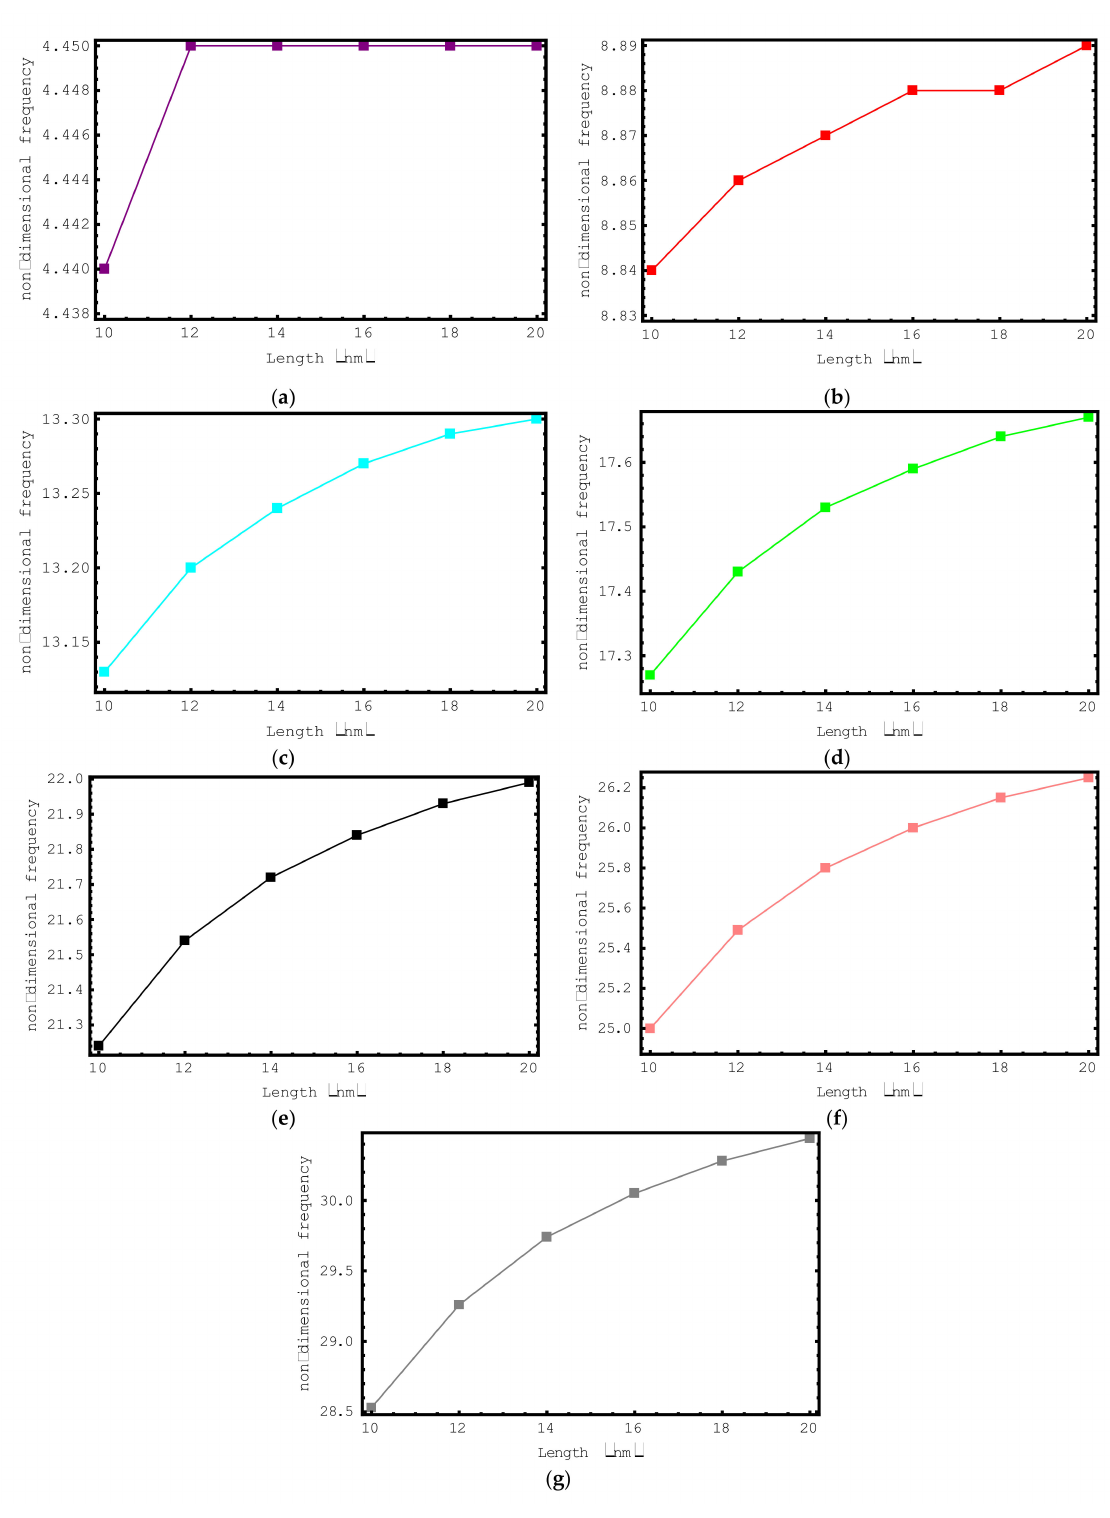
Figure 5. The variations of non-dimensional frequencies of short-fiber-reinforced composite nano- rods versus length: ( a ) 1st mode ( b ) 2nd mode ( c ) 3rd mode ( d ) 4th mode ( e ) 5th mode ( f ) 6th mode ( g ) 7th